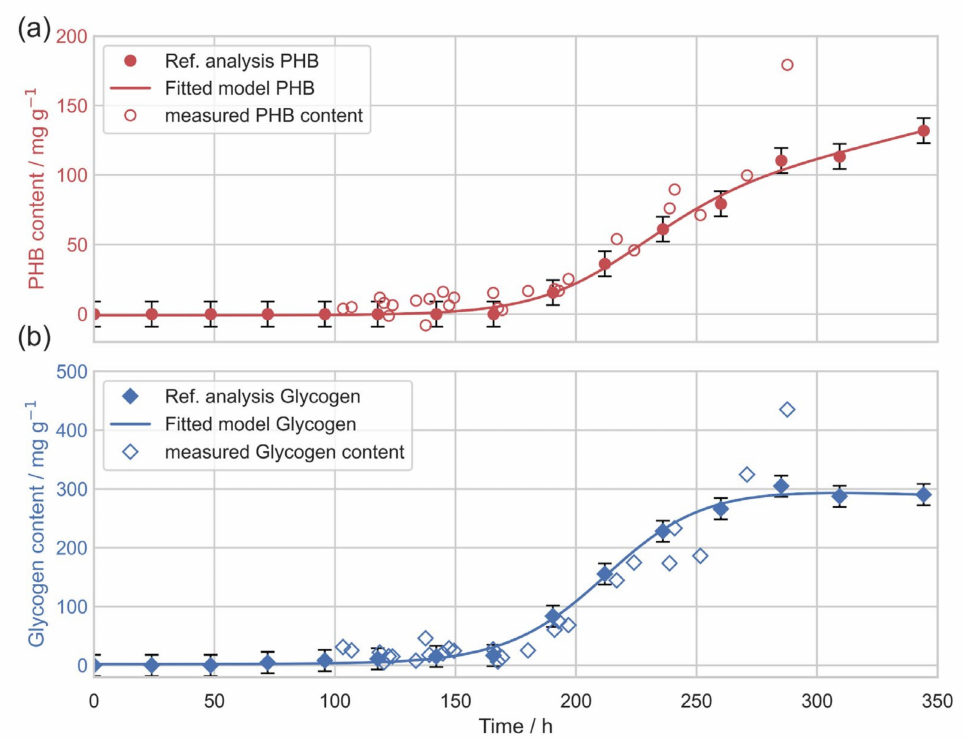
Figure 4. Trend of accumulated storage compounds during Synechocystis sp. PCC 6714 cultivation. ( a ) In-cell PHB; ( b ) glycogen content. Reference analysis was performed offline (filled markers). Profile was modeled to extracted reference points for caught spectra. In-line measured quantities are depicted as unfilled markers. Error bars reflect error of calibration